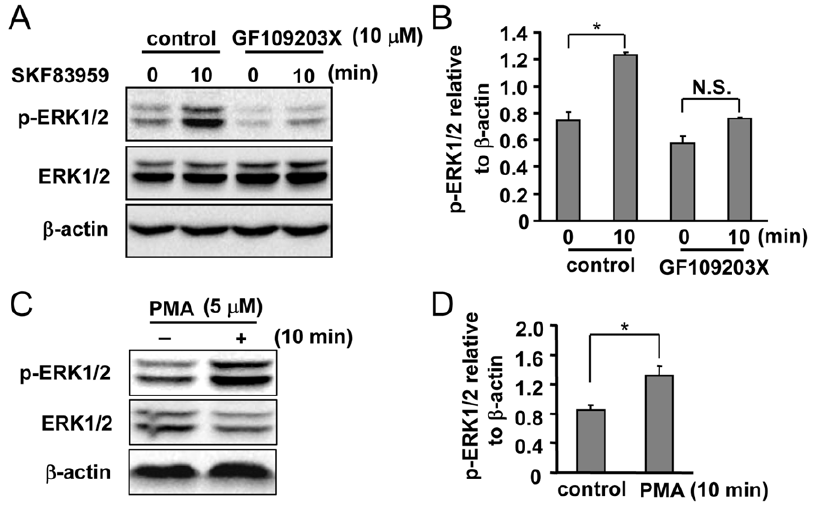
Figure 5. Role of PKC in SKF83959-induced ERK1/2 phosphorylation. (A) Effects of the non-selective PKC inhibitor GF109203X (10 m M, 30 min) on SKF83959 (30 m M, 10 min)-induced ERK1/2 phosphorylation. (B) Quantitative analysis of pretreatment with GF109203X on SKF83959- induced ERK1/2 phosphorylation (Mean 6 S.E., n=3, * P , 0.05, 10 min vs. 0 min). N.S.: no significance. (C) Effects of the specific PKC activator PMA (5 m M, 10 min) on ERK1/2 phosphorylation in cultured astrocytes. (D) Quantification of ERK1/2 phosphorylation level in astrocytes incubated with PMA (5 m M, 10 min) (Mean 6 S.E., n=3, * P , 0.05, vs. control).